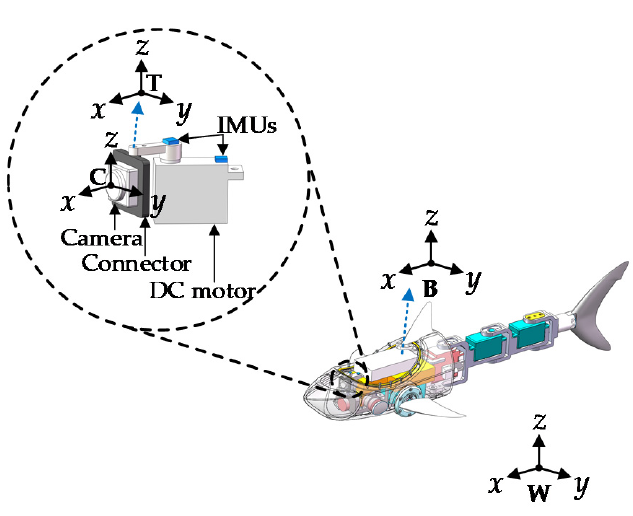
Figure 2. Schematic diagram of the one degree-of-freedom (1-DOF) visual sensor stabilization platform in the shark-like robotic fish.